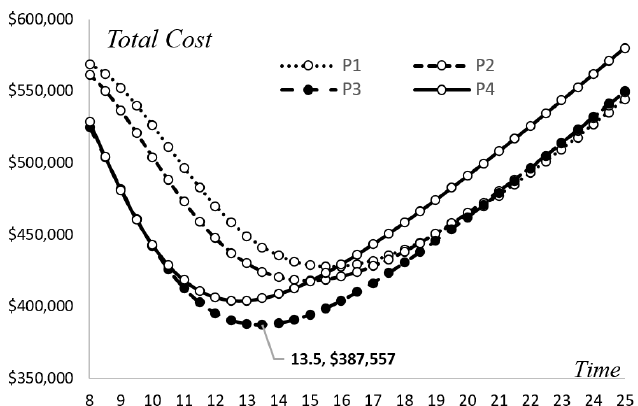
Figure 6. Total Expected Costs for the Four Alternatives.